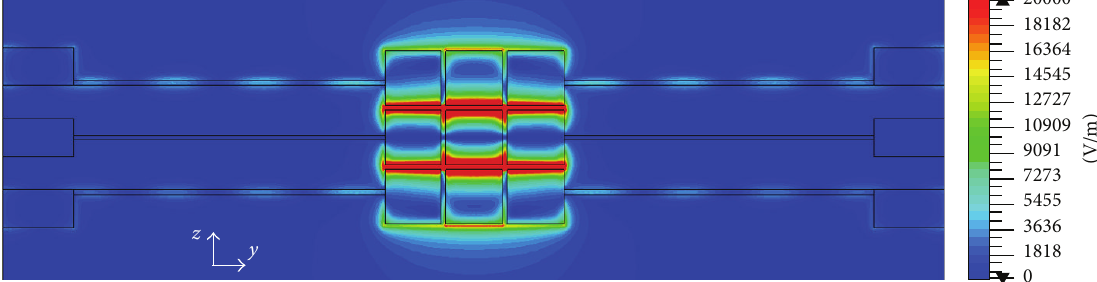
Figure 10: Simulated absolute value of the electric field distribution at 60 GHz at the top surface for the antenna with bias lines feeding network. The antenna total substrate size is 20 mm by 40mm.